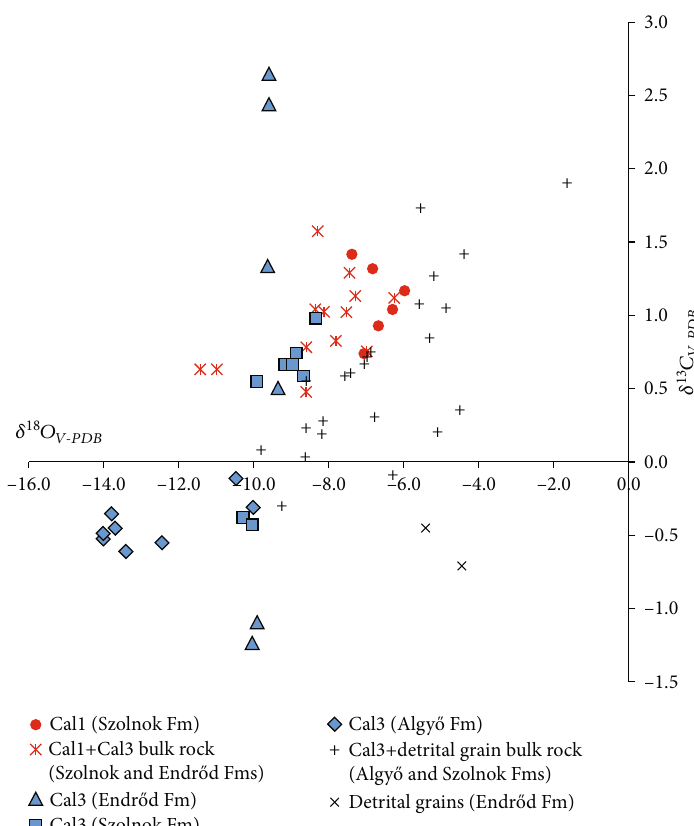
Figure 14: Stable oxygen and carbon isotopic composition of diagenetic and detrital calcite from the studied